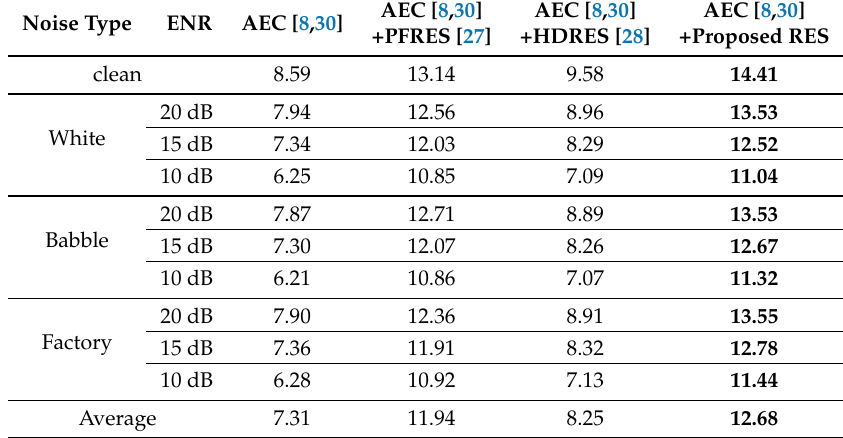
Table 1. Echo return loss enhancement (ERLEs) in various echo-to-noise ratio (ENR) conditions for the acoustic echo canceller (AEC) without residual echo suppression (RES), with the power filter-based RES (PFRES) [27], with the harmonic distortion RES (HDRES) [28], and with the proposed RES during the far-end single-talk periods for the simulated data. The numbers in the bold face indicate the best